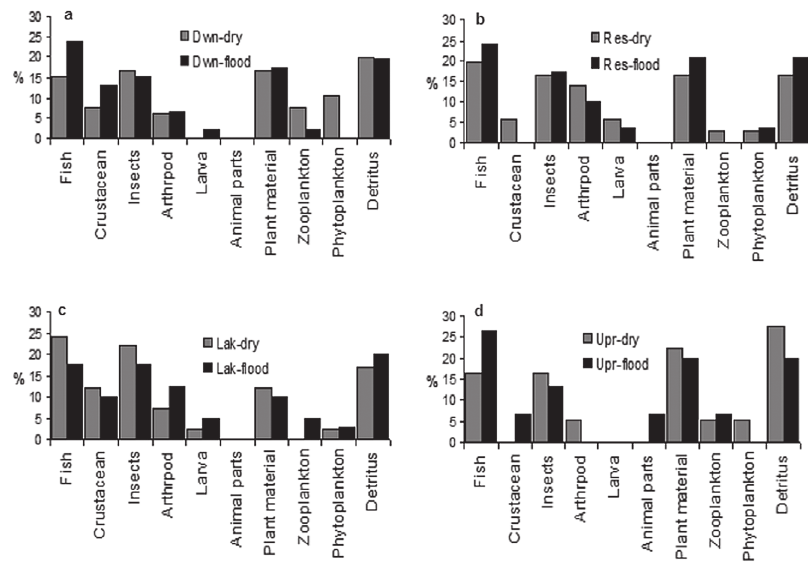
Figure 2 - Fish Fauna diet at areas infl uenced by Coaracy Nunes Dam (Amapá State, Brazil) in dry and fl ood seasons: a) Dwn: Downriver area; b) Res: Reservoir area; c) Lak = Lacustrine area and d) Upr: Upriver